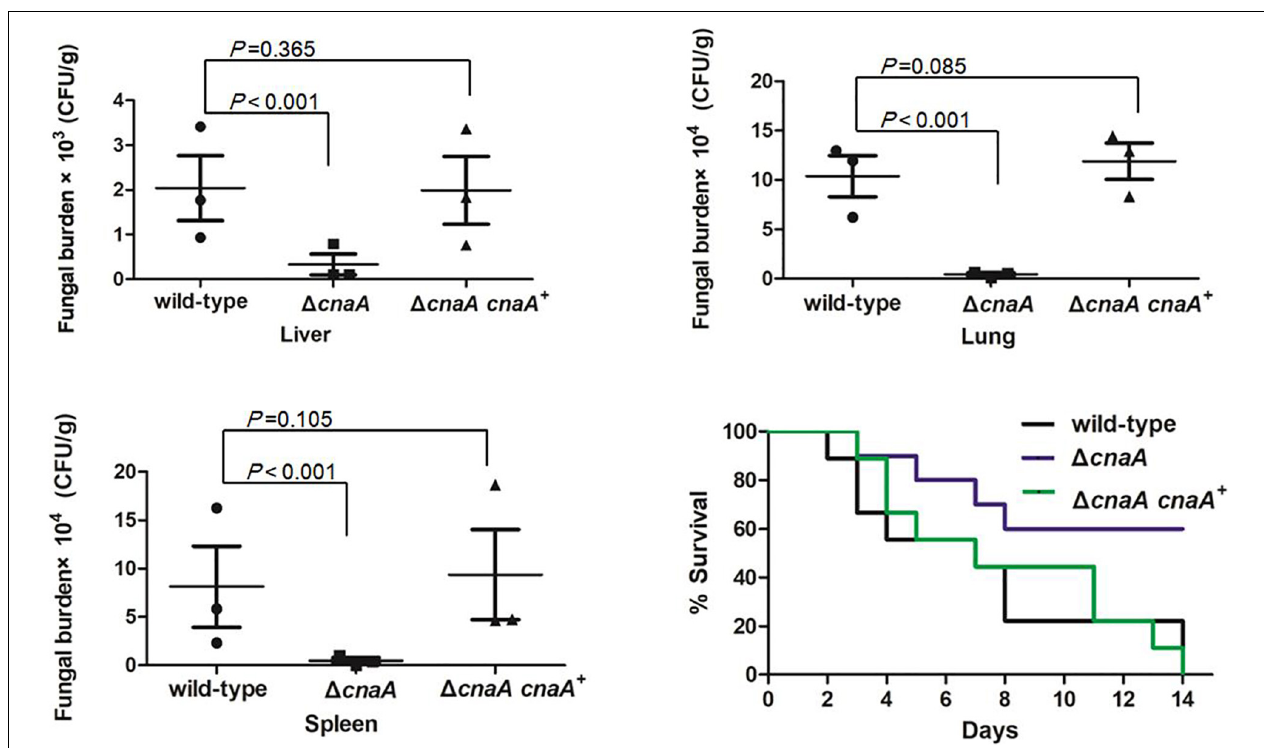
FIGURE 8 | Loss of cnaA abrogates virulence in a murine model of invasive T. marneffei infection. Mice were infected with 10 6 conidia from the wild-type, (cid:49) cnaA or (cid:49) cnaA cnaA + strains by intraperitoneal injection. Organs were harvested 3, 6, or 9 days after infection, and 3 mice were sacrificed every day. Tissue was then assayed for viable T. marenffei . Compared with that for the wild-type and (cid:49) cnaA cnaA + strains, the number of CFU for the (cid:49) cnaA mutant was significantly reduced in lung, hepatic and splenic tissue. The results were statistically significant based on T -test analysis of variance ( P < 0.001) for all comparisons. The morbidity and mortality of infected mice were assessed every day for 14 days. Survival was plotted on a Kaplan-Meier curve and showed that mice infected with the (cid:49) cnaA mutant had a reduced fatality rate (45%) at 14 days compared with the wild-type and (cid:49) cnaA cnaA +